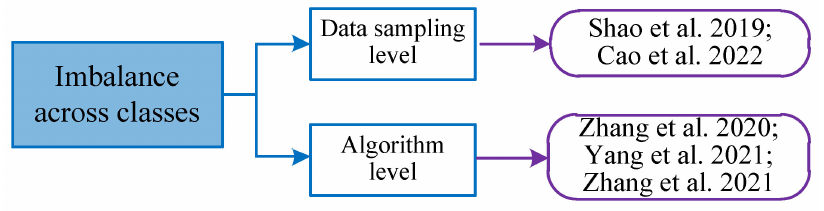
Figure 20. The imbalance across classes in SAR ATR